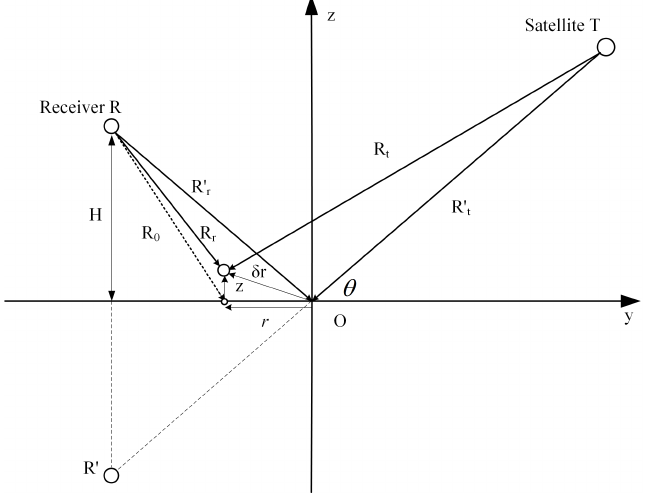
Figure 12. Bistatic geometry of the coastal GNSS-R